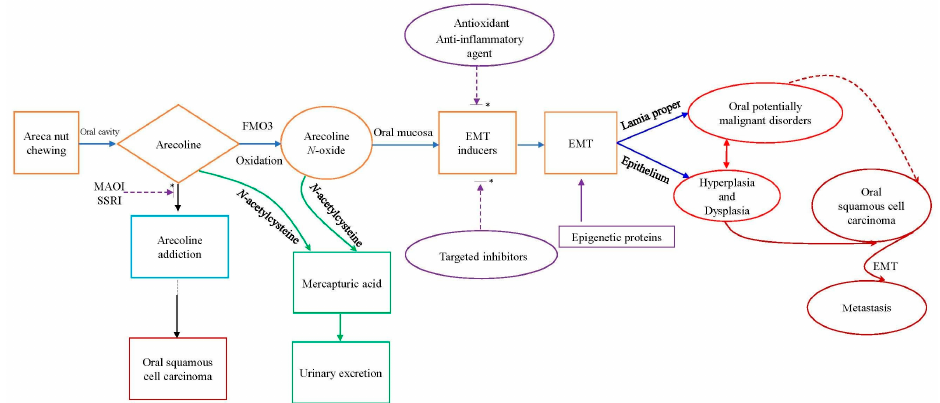
Figure 3. Pathway showing the roles of arecoline and arecoline N -oxide in carcinogenesis. Six steps from cancer initiation and cancer progression: BQ/AN use or addiction; arecoline and arecoline N -oxide formation; EMT inducers activation: ROS formation, cytotoxicity, genotoxicity, and inflam- mation; genetic and epigenetic pathway dysfunction and the EMT induced cancer and metastasis. The pathways sometimes lead to OPMDs before the development of cancer. EMT, epithelial- mesenchymal transition; MAOI: monoamine oxidase inhibitor; and SSRI, selective serotonin reuptake inhibitors. EMT inducers: reactive oxygen species, transforming growth factor beta-1, Notch receptor- 1, interleukin-1beta, and interleukin-6. EMT markers: E-cadherine. S100 calcium-binding protein A4, zinc fi nger E-box-binding homeobox-1, and alpha smooth muscle actin. Epigenetics: sirtuin-1